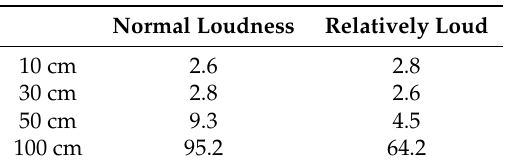
Table 4. Mean time spent (seconds) by audio wave transmission framework before the device recognized the credential